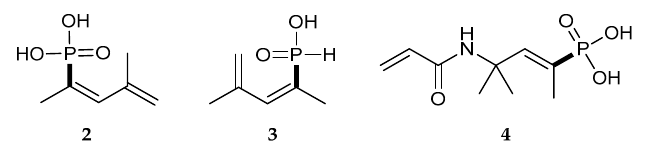
Figure 1. Chemical structures of 1a and 1b and their counter ion − OTs .